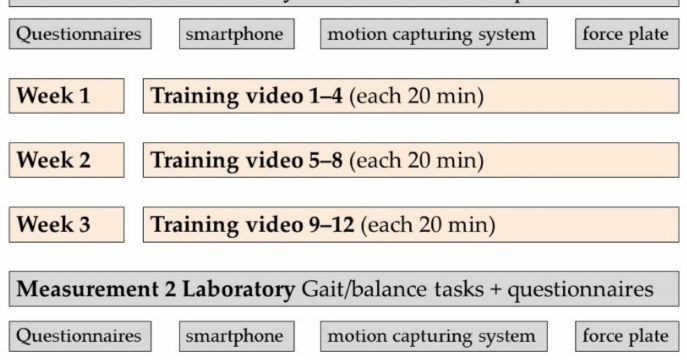
Figure 1. Overview of study